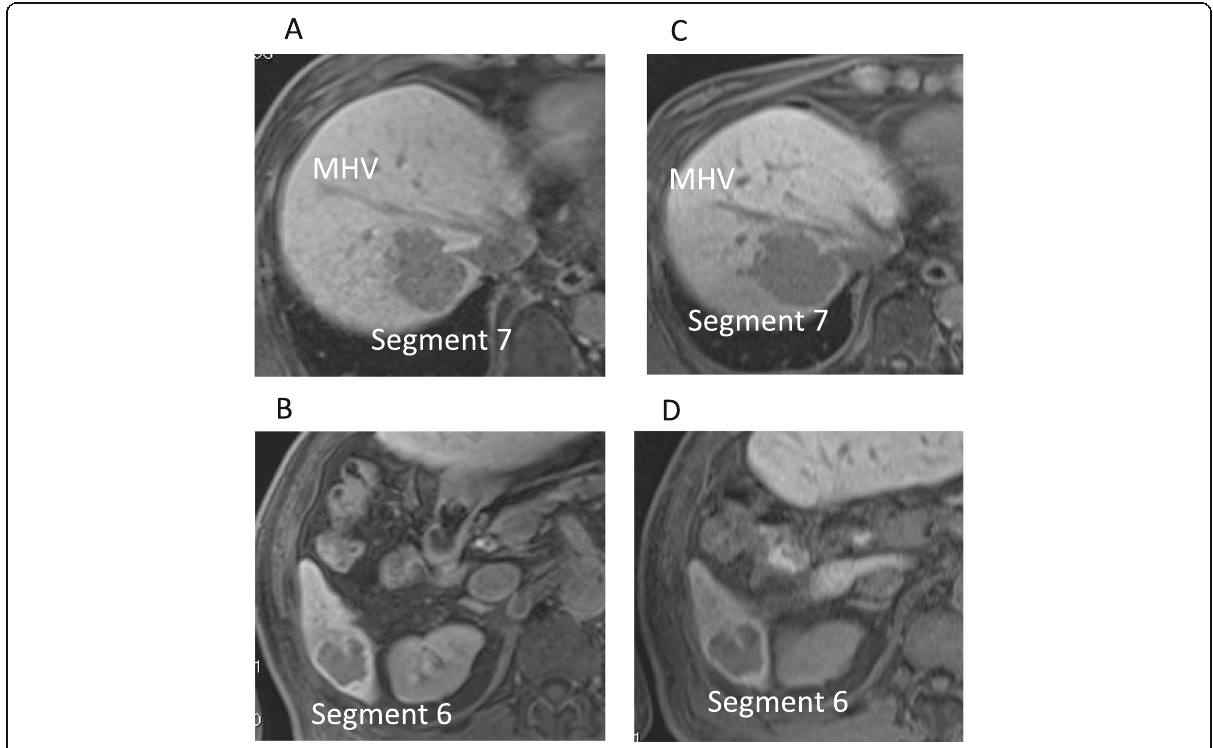
Fig. 2 MRI imaging of HCC. a MRI showing the tumor located in segment 7 at the first visit. b MRI shows the tumor located in segment 6 at the first visit. c MRI shows the tumor located in segment 7 before hepatic resection. The tumor grew to 5.1 cm 10 weeks after the first visit. d MRI showing the tumor located in segment 6 before hepatic resection. The tumor grew to 3.1 cm 10 weeks after the first visit. MRI, magnetic resonance image; HCC, hepatocellular carcinoma; CT, computed